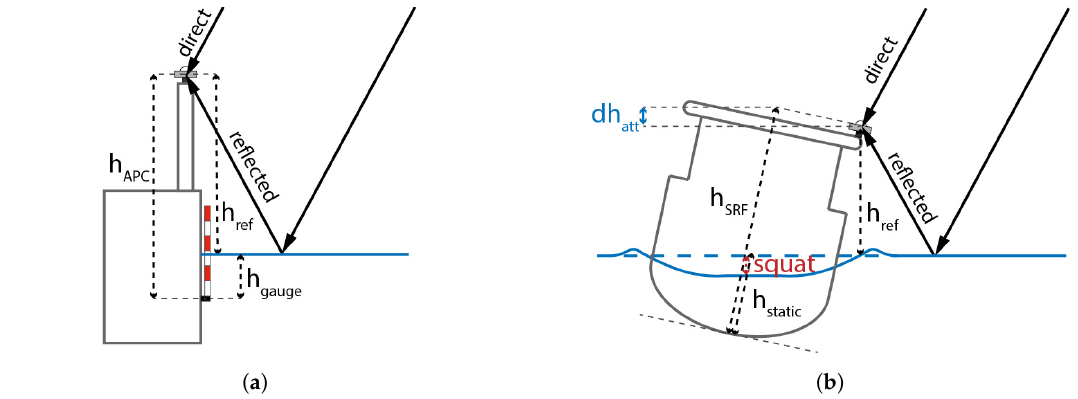
Figure 2. Schematic diagrams of the geometries and connections between the parameters of Equations (2) and (3). ( a ) Geometry for a static antenna. ( b ) Geometry for a ship-based